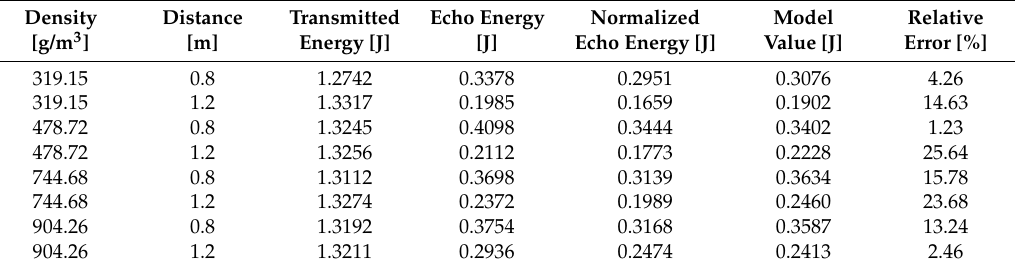
Table 10. Canopy density model universal analysis with four layers of